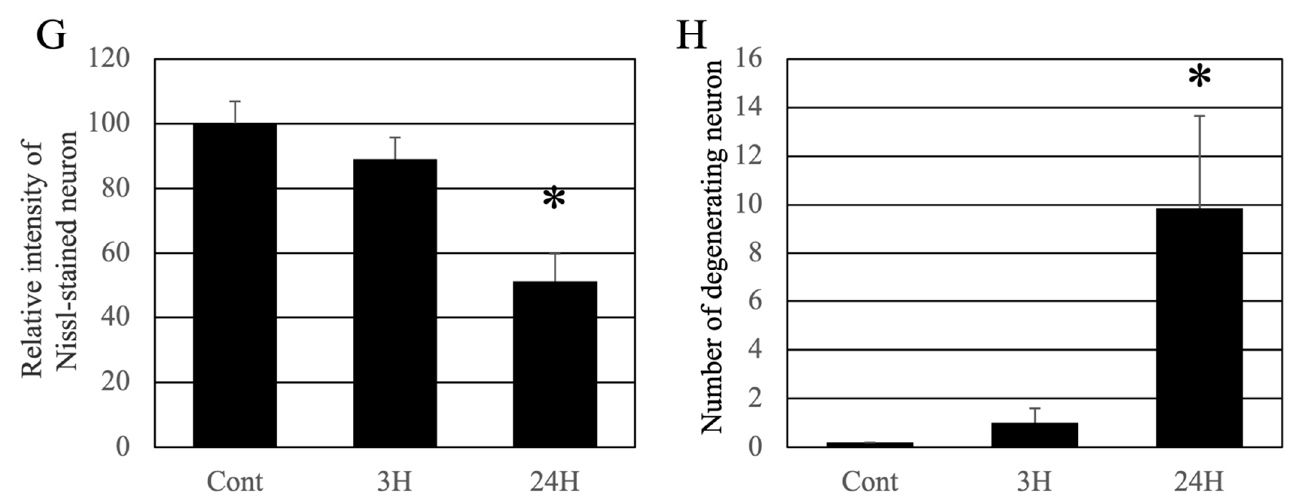
Figure 5. Control ( A , D ), 3H ( B , E ), and 24H ( C , F ) representative optical images of the cerebral cortical tissues from the control animals and those from animals sacrificed at 3 h and 24 h after ammonia treatment, respectively. ( A – C ) are high-magnification views of the hematoxylin-eosin-stained cerebral cortical tissues. ( D – F ) are high-magnification views of the Nissl-stained cerebral cortical tissues. The black arrows indicate perivascular edema of the cerebral cortex layer II/III. Red arrowheads indicate the swollen fibers of the cerebral cortex layer II/III. Black arrowheads indicate the neuronal atrophy of the cerebral cortex layer II/III. All scale bars = 100 µm. ( G ) shows the relative intensity of Nissl-stained neurons. Data are shown as relative intensity (100 = the intensity of the control value). ( H ) shows the number of atrophying neurons. Data are expressed as mean ± standard deviation. *: p < 0.05 compared with the control value.